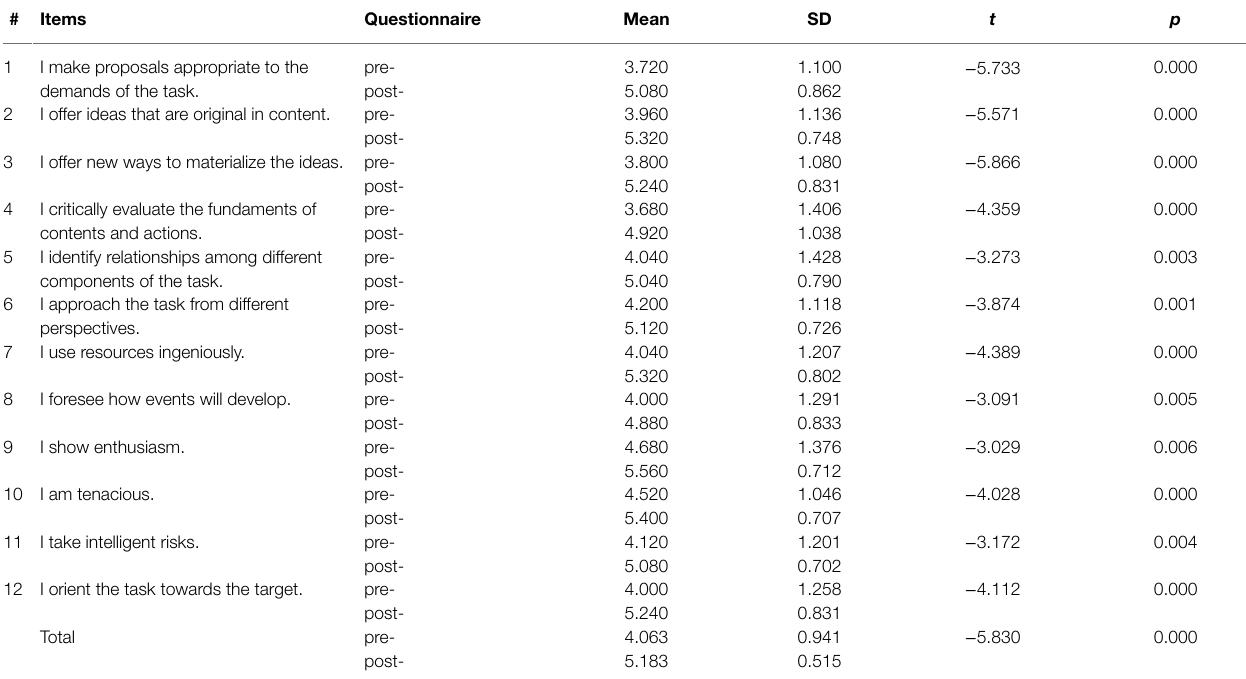
TABLE 2 | Perceived innovation before and after learning activities.